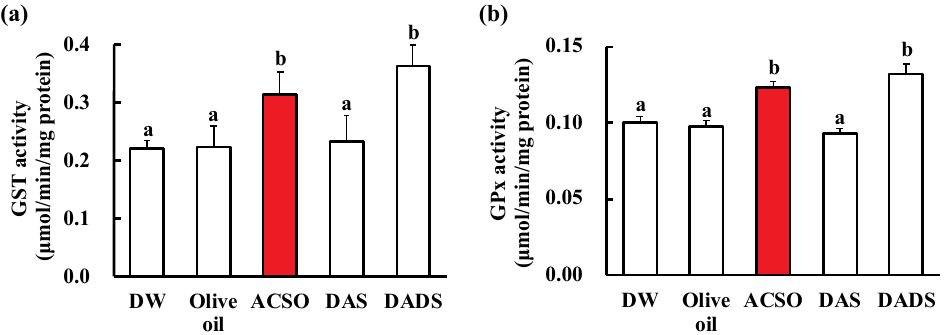
Figure 5. Effect of ACSO and sulfides on liver function. GST activity ( a ) and GPx activity ( b ) in the livers of normal rats after administration of CCl 4 . Each value represents the mean of six rats ± S.E. The different letters in the figures indicate a significant difference between the groups ( p < 0.01).